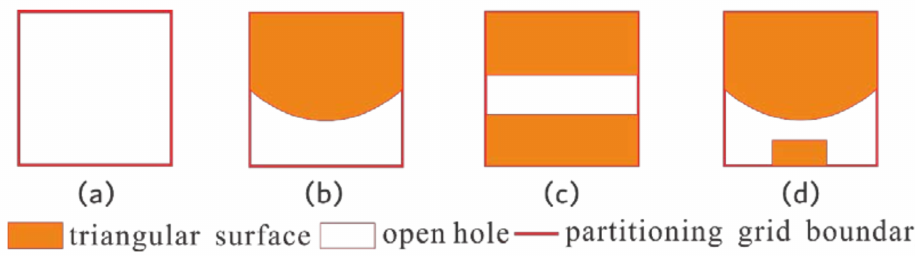
Figure 5. Fine classification of open holes: ( a ) type A; ( b ) type B; ( c ) type C; ( d ) type D.